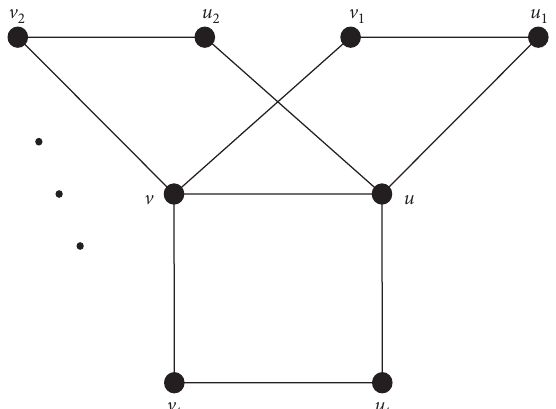
Figure 1: A book graph B